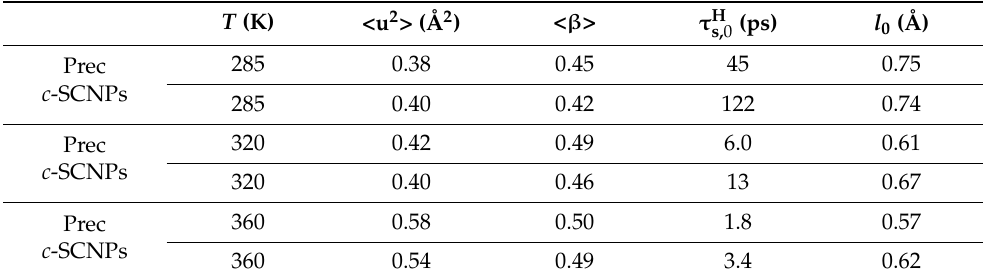
Table 1. Values of the parameters involved in the AJD fitting the Prec and c -SCNPs results described with KWW functions.